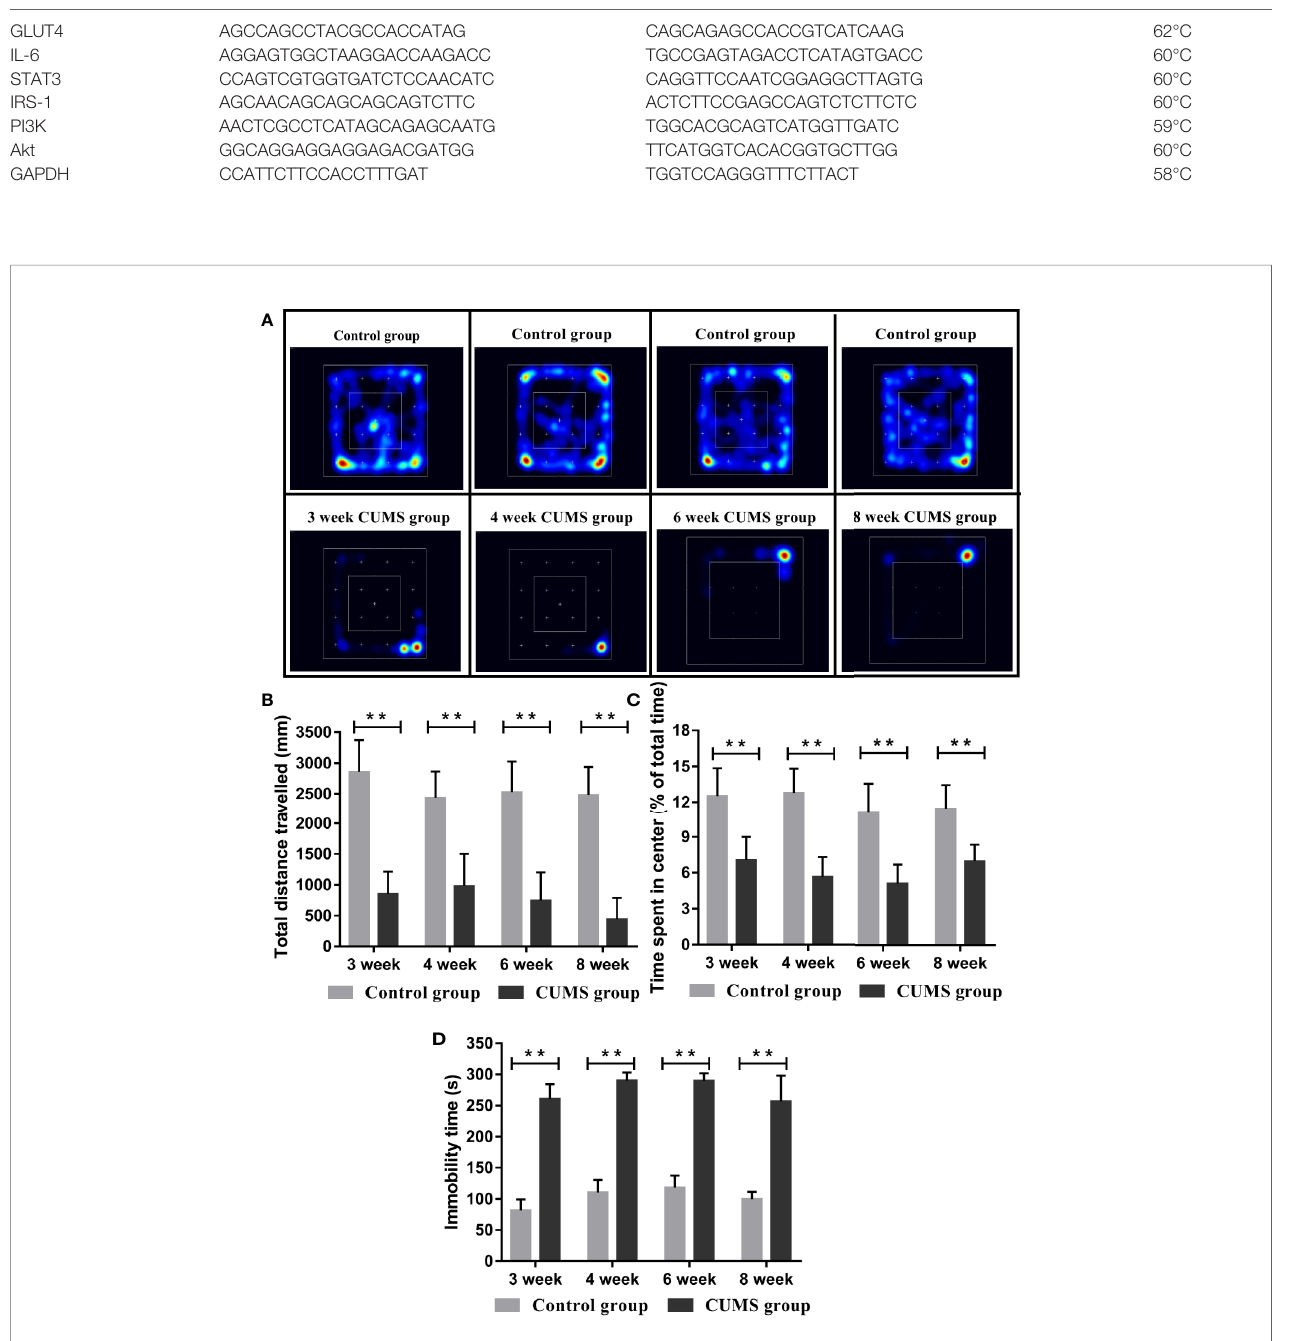
FIGURE 2 | Effect of CUMS exposure on the depression-like behavior of rats. (A) Heat maps of the OFT. (B) Total distance travelled in the OFT. (C) Time spent in the center in OFT. (D) Immobility time in the FST. Data are presented as mean ± SD, n = 10; **p < 0.01 vs. Control group. Figure 4A . In the control group, the hepatocytes showed well- enlarged cellular bodies and transparent cytoplasm with preserved cytoplasm and clear nuclei, which were closely packed ballooning degeneration were also observed. and regularly structured. The well-arranged hepatocytes with To con fi rm whether CUMS affected the size of adipocytes, the center nuclei were also seen in the CUMS group; however, rat adipose tissues were stained using H&E staining. The